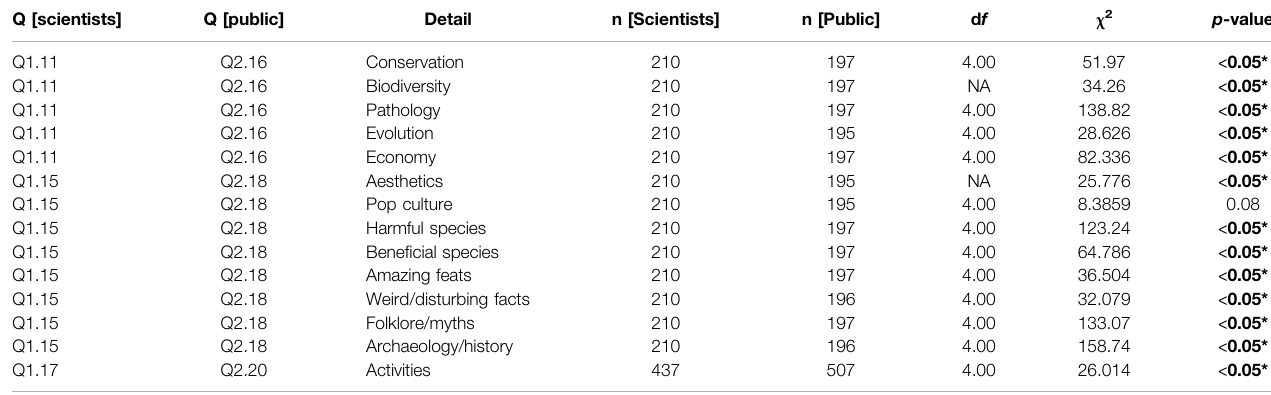
TABLE 1 | Results of the Pearson ’ s chi-squared tests comparing the distribution of answers of scientists (Part 1: Q1.11, Q1.15, and Q1.17) and the public (Part 2: Q.2.16, Q21 Q2.18, and Q2.20). Each line represents a different test. Signi fi cant results are shown in bold